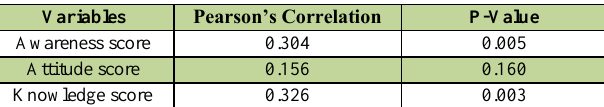
Table 4: Determination relationship among awareness, attitude, and knowledge of students concerning EBD with their average score in the previous